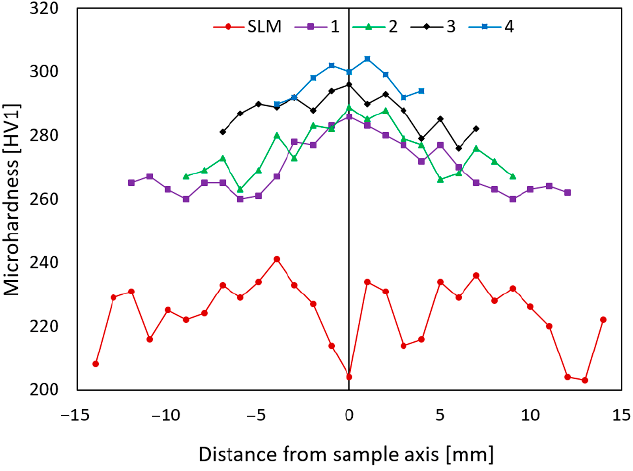
Figure 6. Distributions of the HV1 microhardness values across the cross-sections of the examined samples.